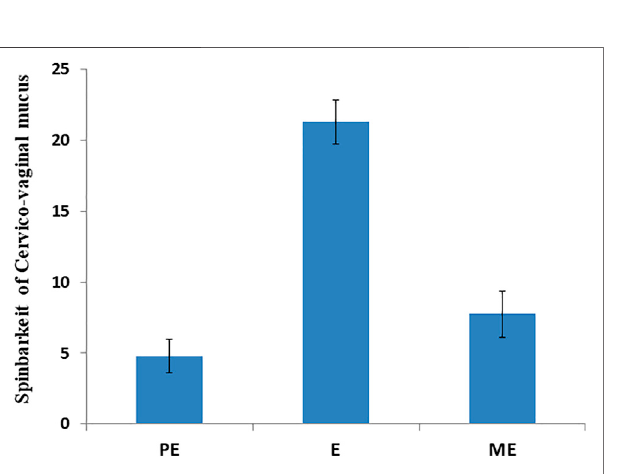
Frontiers in Genetics |